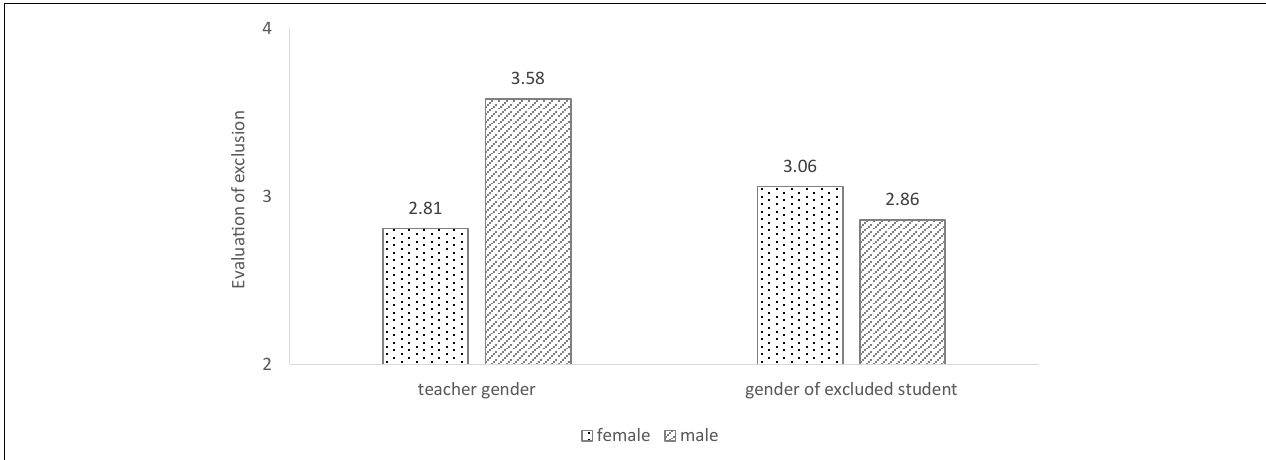
FIGURE 1 | Evaluation of exclusion as a function of teacher gender and the gender of the excluded student. High numbers indicate high acceptability of exclusion; low numbers indicate strong rejection of exclusion.